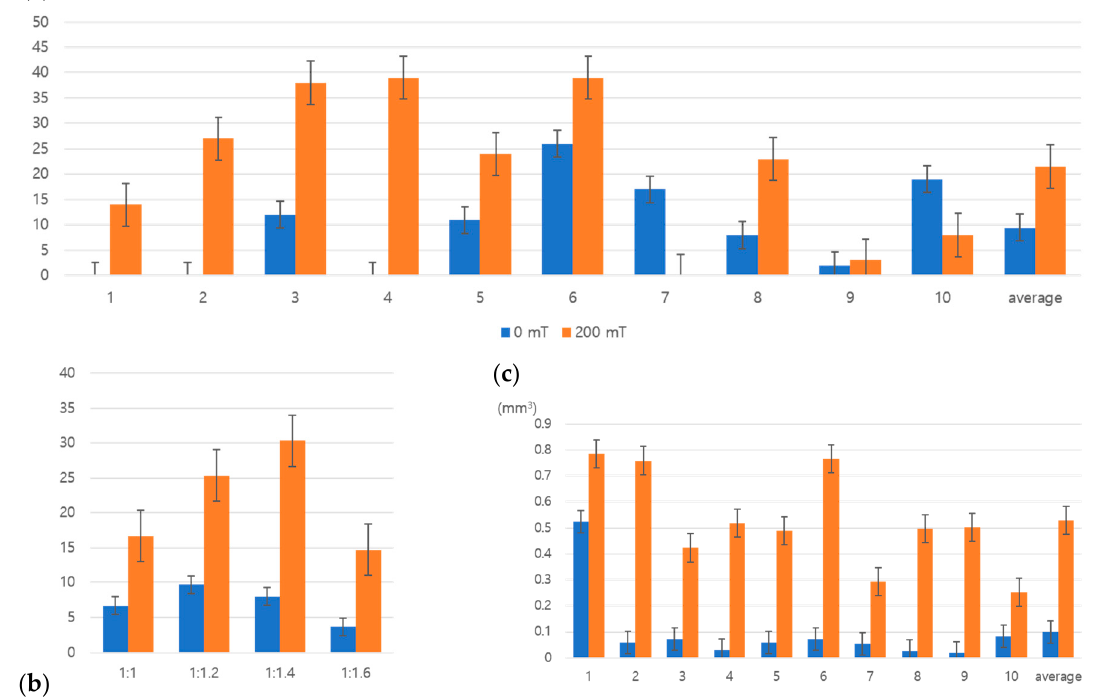
Figure 9. Comparison of the ENR crystal growth under a magnetic field. Number of crystallization screening hits under the magnetic field. ( a ) Number of crystals per well. ( b ) Number of crystals based on protein solutions per reservoir ratio. ( c ) Volume (a × b × c) of the crystals.